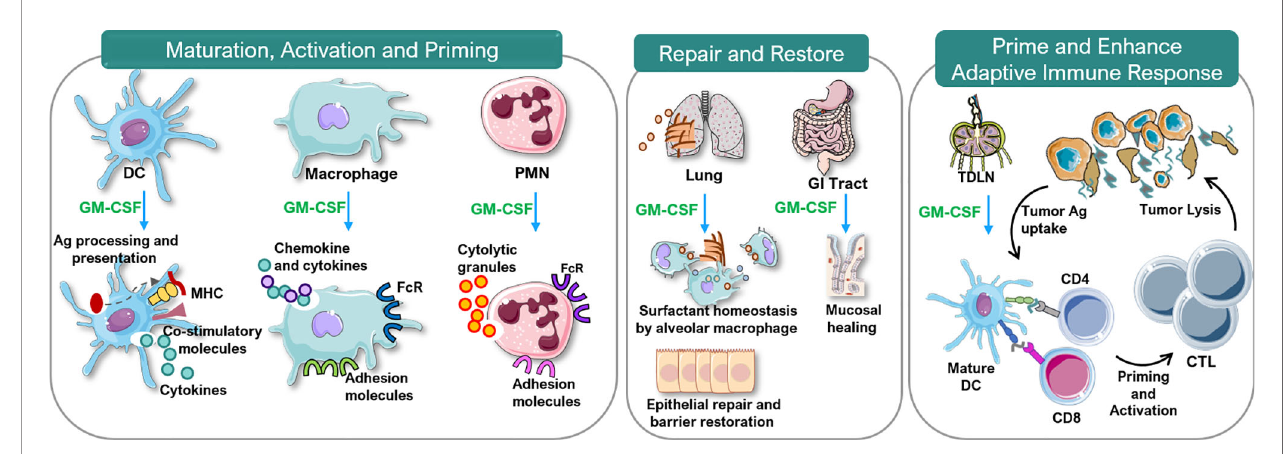
FIGURE 4 | Immunobiology of GM-CSF. Ag, antigen; CTL, cytotoxic T lymphocytes; DC, dendritic cell; FcR, Fc receptor; GM-CSF, granulocyte-macrophage colony-stimulating factor; MHC, major histocompatibility complex; PMN, polymorphonuclear neutrophils; TDLN, tumor-draining lymph node. This fi gure was